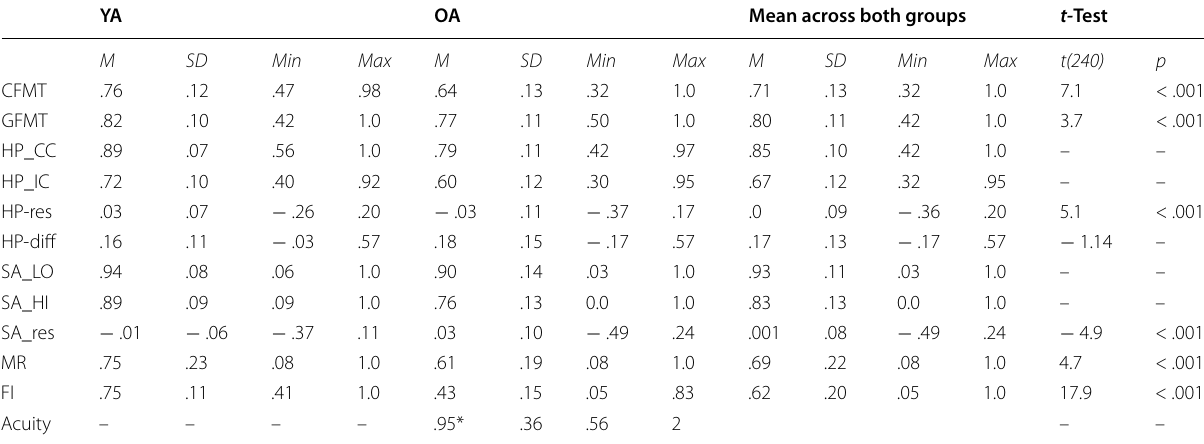
Table 1 Mean Performance (M) and Standard Deviation (SD) in Young and Older Adults Groups, as well as age‑related differences, for all tasks used in this